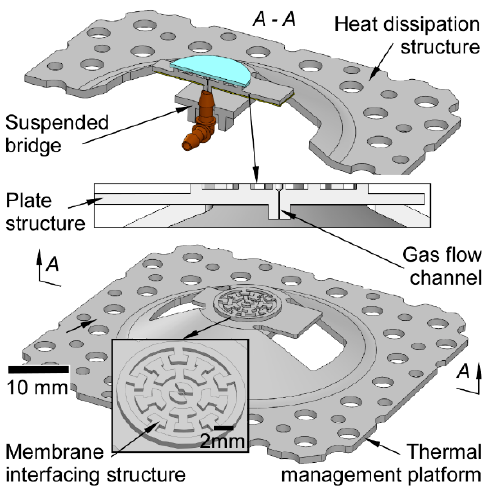
Figure 4. The model of the 3D-printed thermal management platform. Each thermal management platform consists of a heat dissipation structure, a plate structure to interface with the heater, a membrane interfacing structure, a suspended bridge, and a gas flow channel to route the flow from the membranes to the outside.